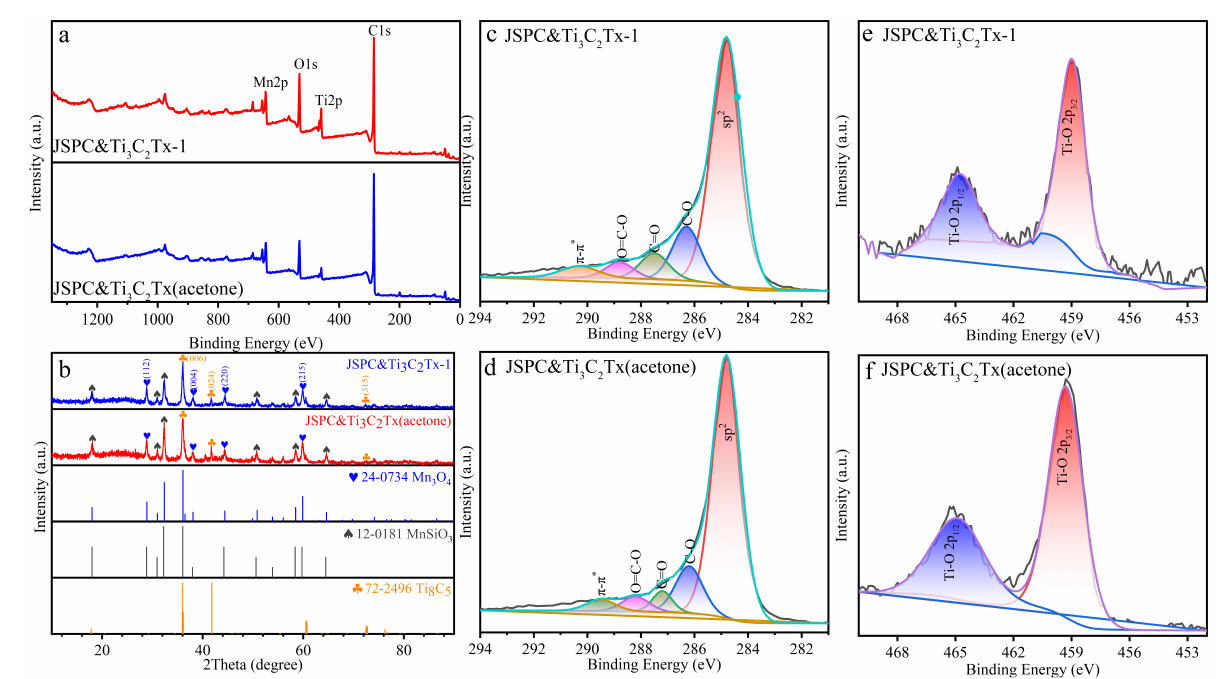
Figure 2. XPS survey spectra ( a ), XRD patterns ( b ) and high-resolution spectrum (( c , e ): C1s and Ti 2p of JSPC&Ti 3 C 2 Tx-1; ( d , f ): C1s and Ti 2p of JSPC&Ti 3 C 2 Tx (acetone)).